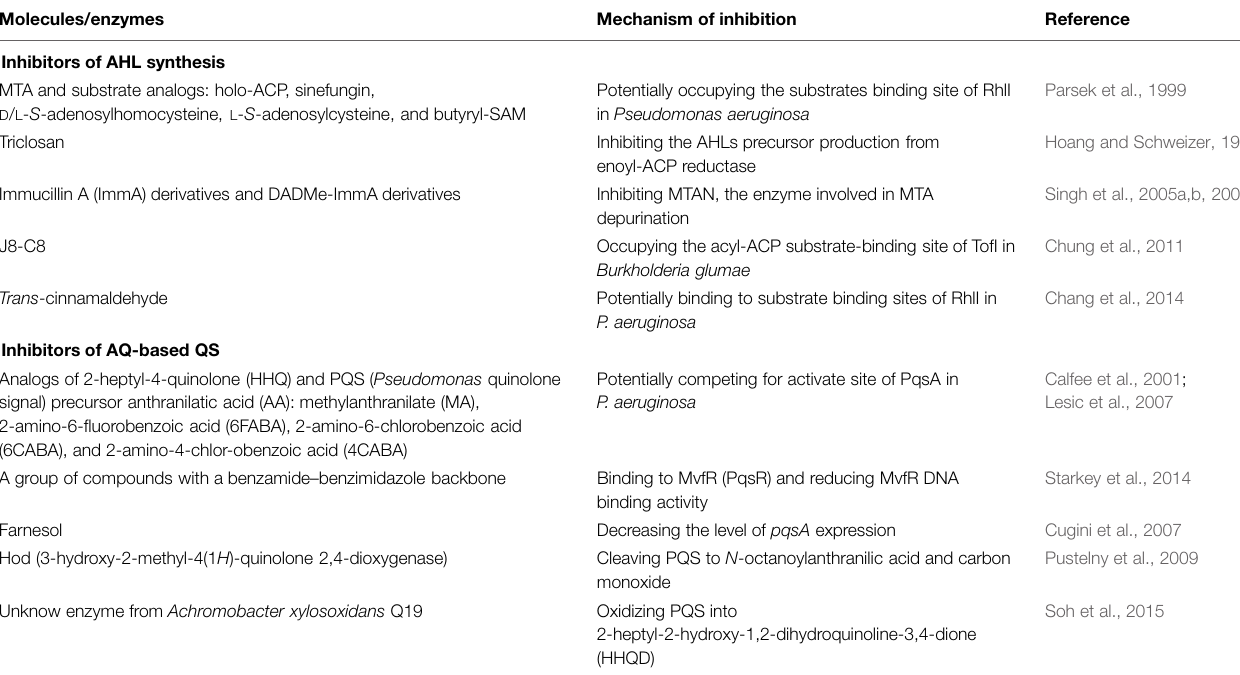
TABLE 1 | Overview of inhibitors on N -acyl-homoserine lactone (AHL) synthesis and on alkylquinolone (AQ)-mediated quorum sensing (QS)